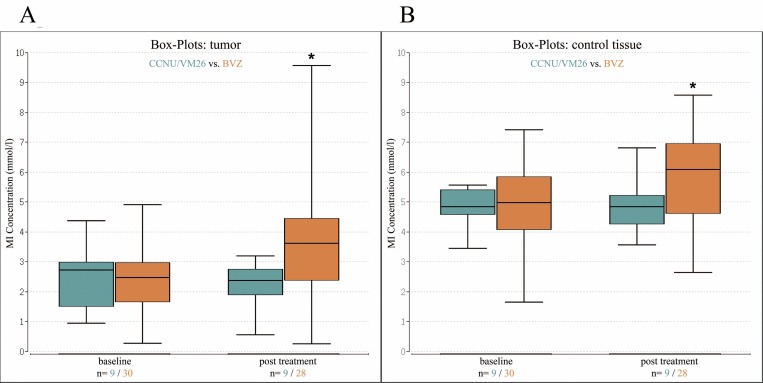
Box-Whisker-plots.(A) Box-Whisker-plot showing the median (baseline CCNU/VM26 = 2.73, BVZ = 2.47; post treatment CCNU/VM26 = 2.38, BVZ = 3.61) and quartiles for tumor at baseline and post treatment for BVZ (orange) and CCNU/VM26 (blue). (B) Box-Whisker-plot showing the median (baseline CCNU/VM26 = 4.83, BVZ = 4.97; post treatment CCNU/VM26 = 4.83, BVZ = 6.08) and quartiles for the control tissue at baseline and post treatment for BVZ (orange) and CCNU/VM26 (blue). Each * marks a significant increase from baseline to post treatment.